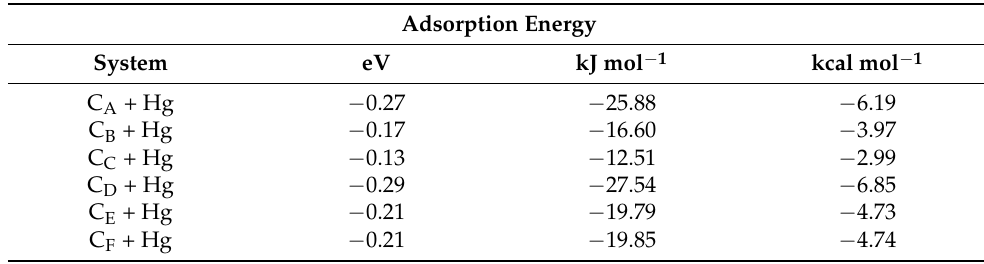
Table 7. Adsorption energy predicted by Gaussian16 of the different rGO–Hg systems considered in the present